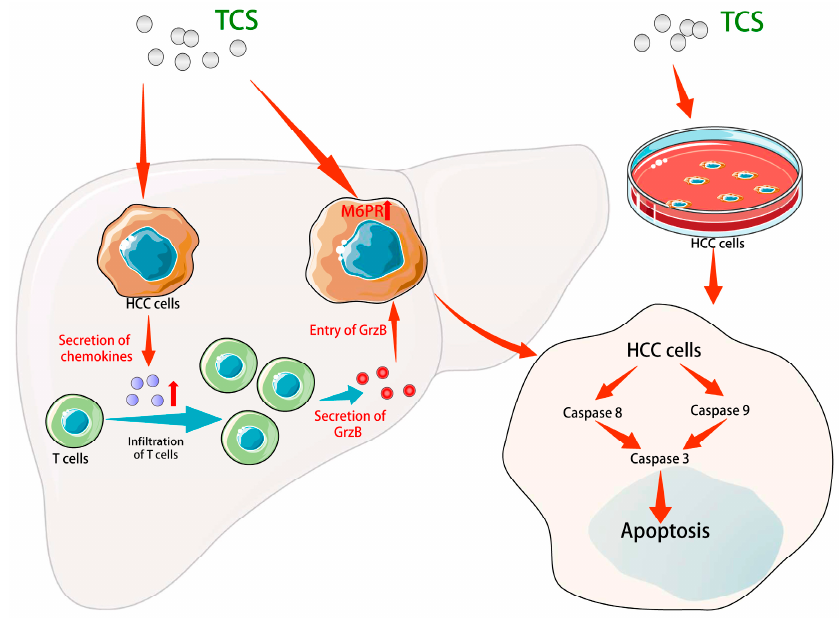
Figure 9. Diagram showing the molecular mechanism of TCS on anti-tumor activity. TCS stimulated the expression of chemokines CCL2, CCL17 and CCL22, which may encourage the enrichment of CD8 + T cells within HCC tissue. GrzB secreted by the T cells were transported into the HCC cells by cellular M6PR and facilitated cell apoptosis. TCS-induced caspases mediated apoptosis both in vivo and in vitro .